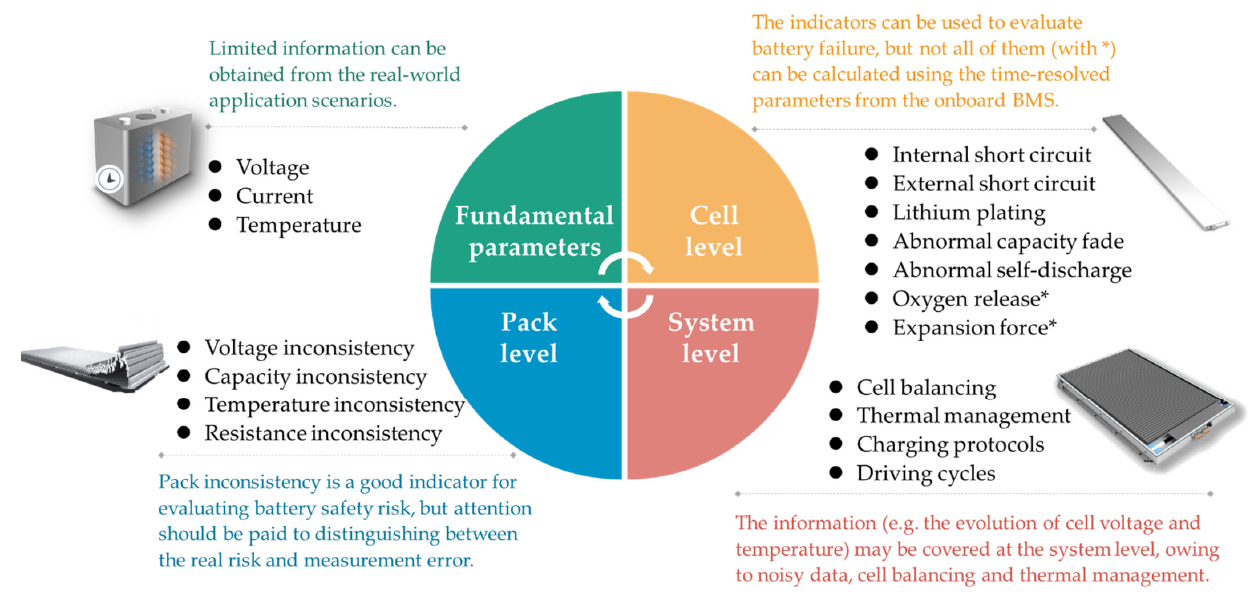
Figure 3. Full-scale feature engineering in the data-driven prediction of battery failure for EVs. The detailed description of battery failure level can be found in the European Council for Automotive R&D (EUCAR) report [64].